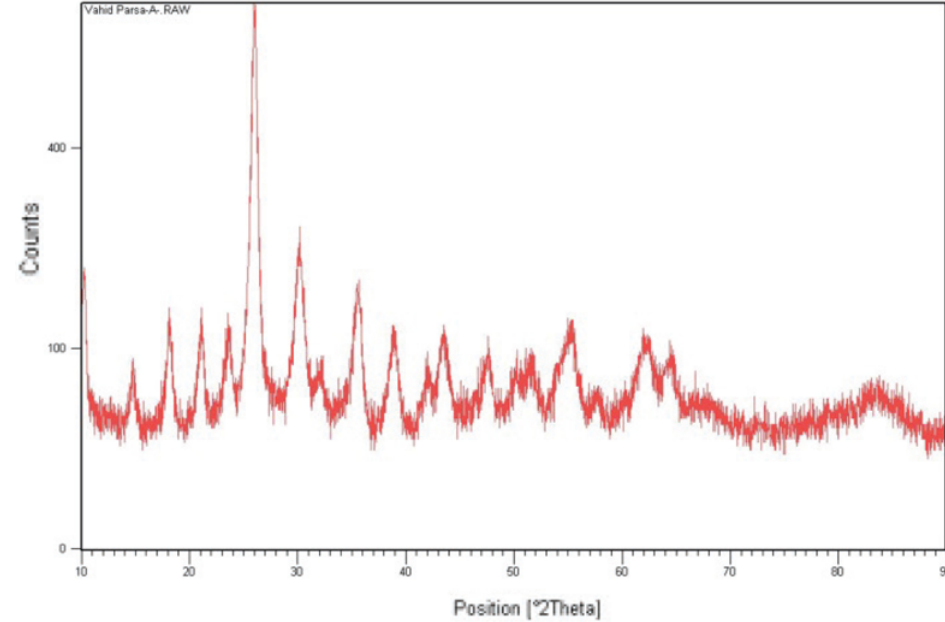
Fig. 2. The XRD of nano-Rb